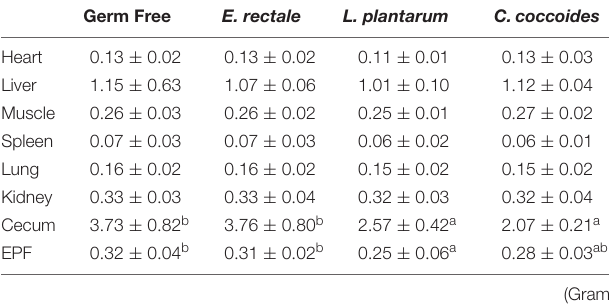
TABLE 3 | The body compositions in indicated gnotobiotic